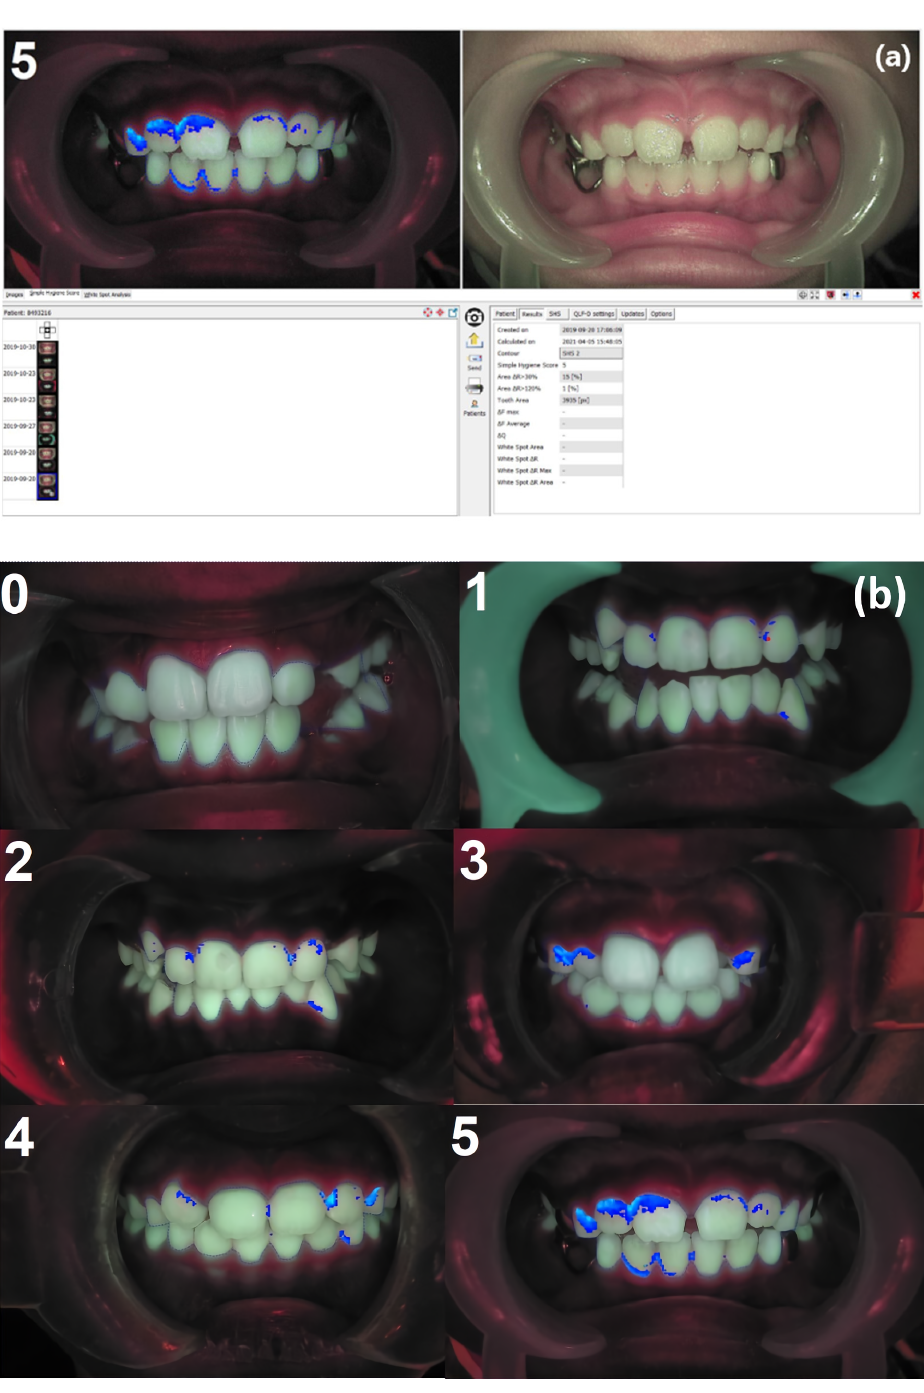
Figure 5. ( a ) Fluorescent plaque index (FPI) analysis using propriety software of the quantitative light-induced fluorescence system. ( b ) Representative fluorescent images with the simple hygiene score (SHS) in the left upper corner. Quantitative and qualitative assessments of dental plaque deposits were performed, and scores ranging from zero to five points were assigned according to the attached area of dental plaque.